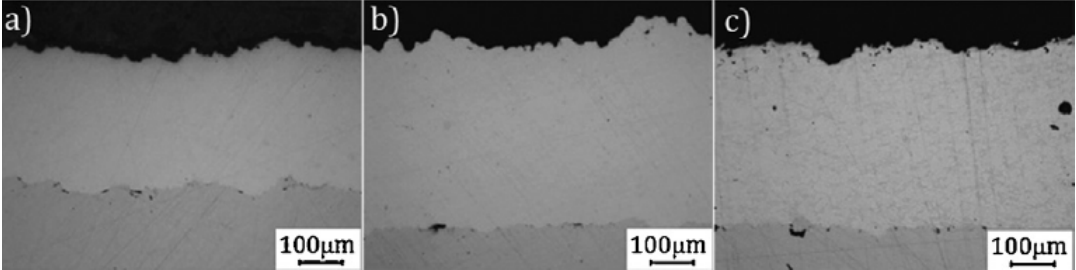
Figure 12. SEM micrographs of deposited ( a ) Stellite 6, ( b ) Stellite 31 and ( c ) Stellite 31 + 10% AISI 316L coatings observed in cross ‐ section [48]. Copyright 2015 Elsevier.